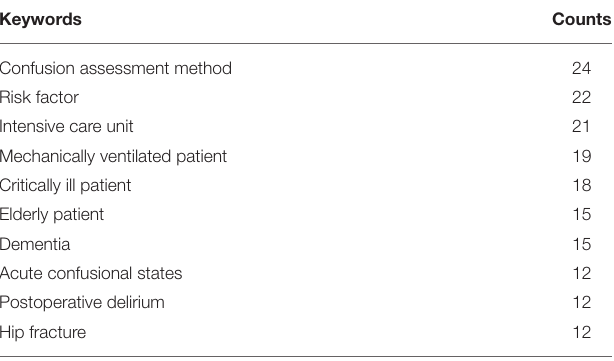
TABLE 4 | The top-10 keywords with the highest frequency of co-occurrence.